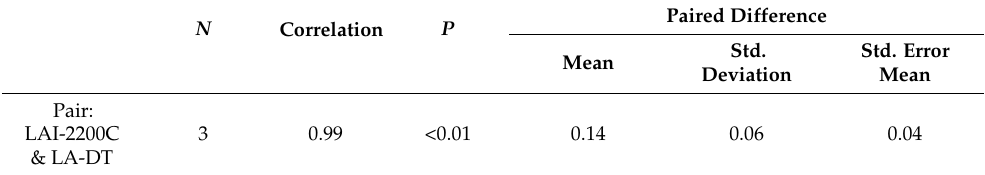
Figure 7. Statistical bar graph of total LA estimates for LAI-2200C and LA-DT.